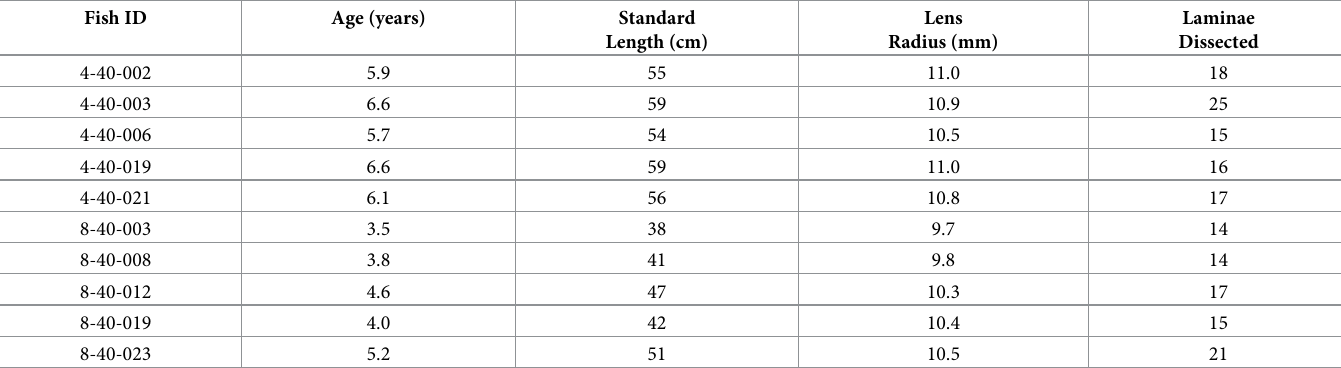
Table 1. Individual Red Snappers used in the CSIA-AA.